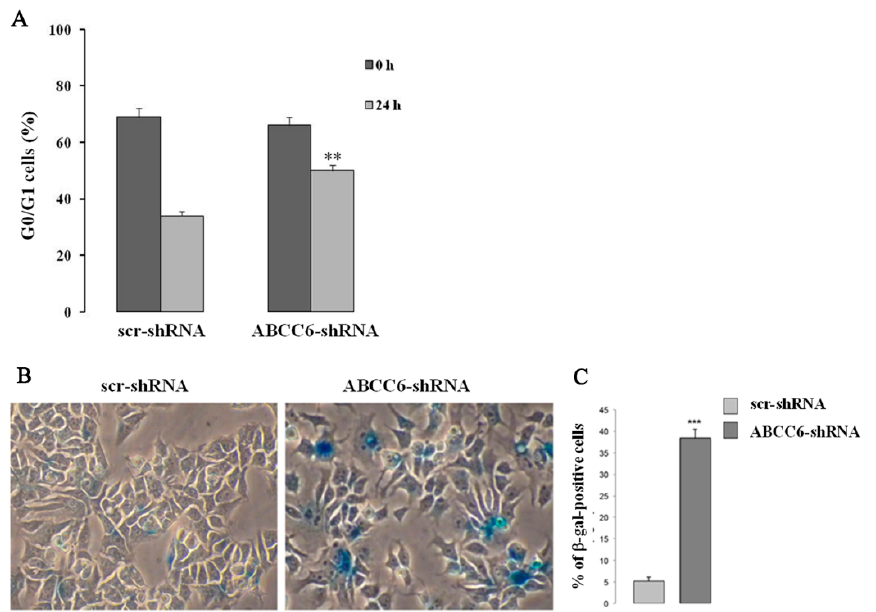
Figure 5. Pictorial presentation of senescent-like phenotype in ABCC6 knockdown HepG2 cell. ( A )—For the cell cycle analysis, the cells were synchronized at the G1 phase by serum deprivation for 24 h, restimulated with serum for 24 h, and analyzed using flow cytometry after BrDU and PI staining. The percentage of control (scr-shRNA) and ABCC6 knockdown cells (ABCC6-shRNA) in G0/G1 was recorded. ( B )—Representative images (40 × magnification) of senescence-associated β -galactosidase staining in control and ABCC6 knockdown cells. ( C )—Quantitative analysis of positive β -galactosidase-stained cells. Data were generated from three independent experiments performed in triplicate and are shown as means ± SD. Statistical analysis was performed using unpaired Student’s t test: ** p < 0.01 and *** p < 0.001 [33]. Interestingly, knockdown HepG2 cells were shown to have a decreased expression of the ecto-5 ′ -nucleotidase ( NT5E or CD73), which regulates the conversion of AMP to